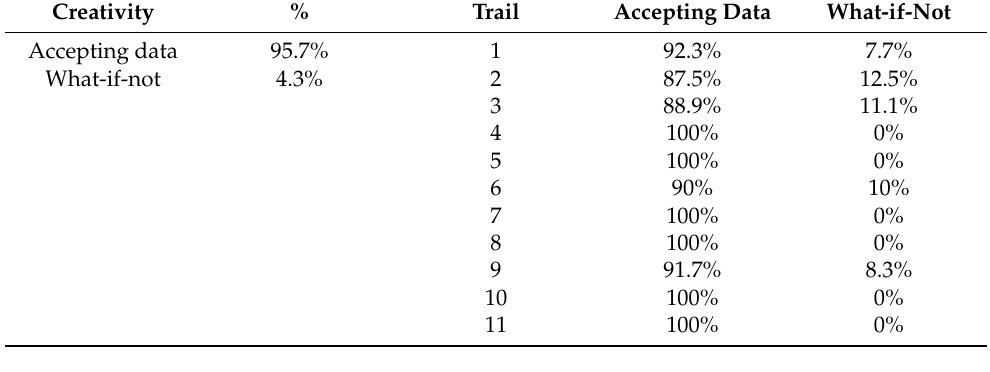
Table 9. Problem-posing type ( Creativity variable) and breakdown for each trail. Creativity